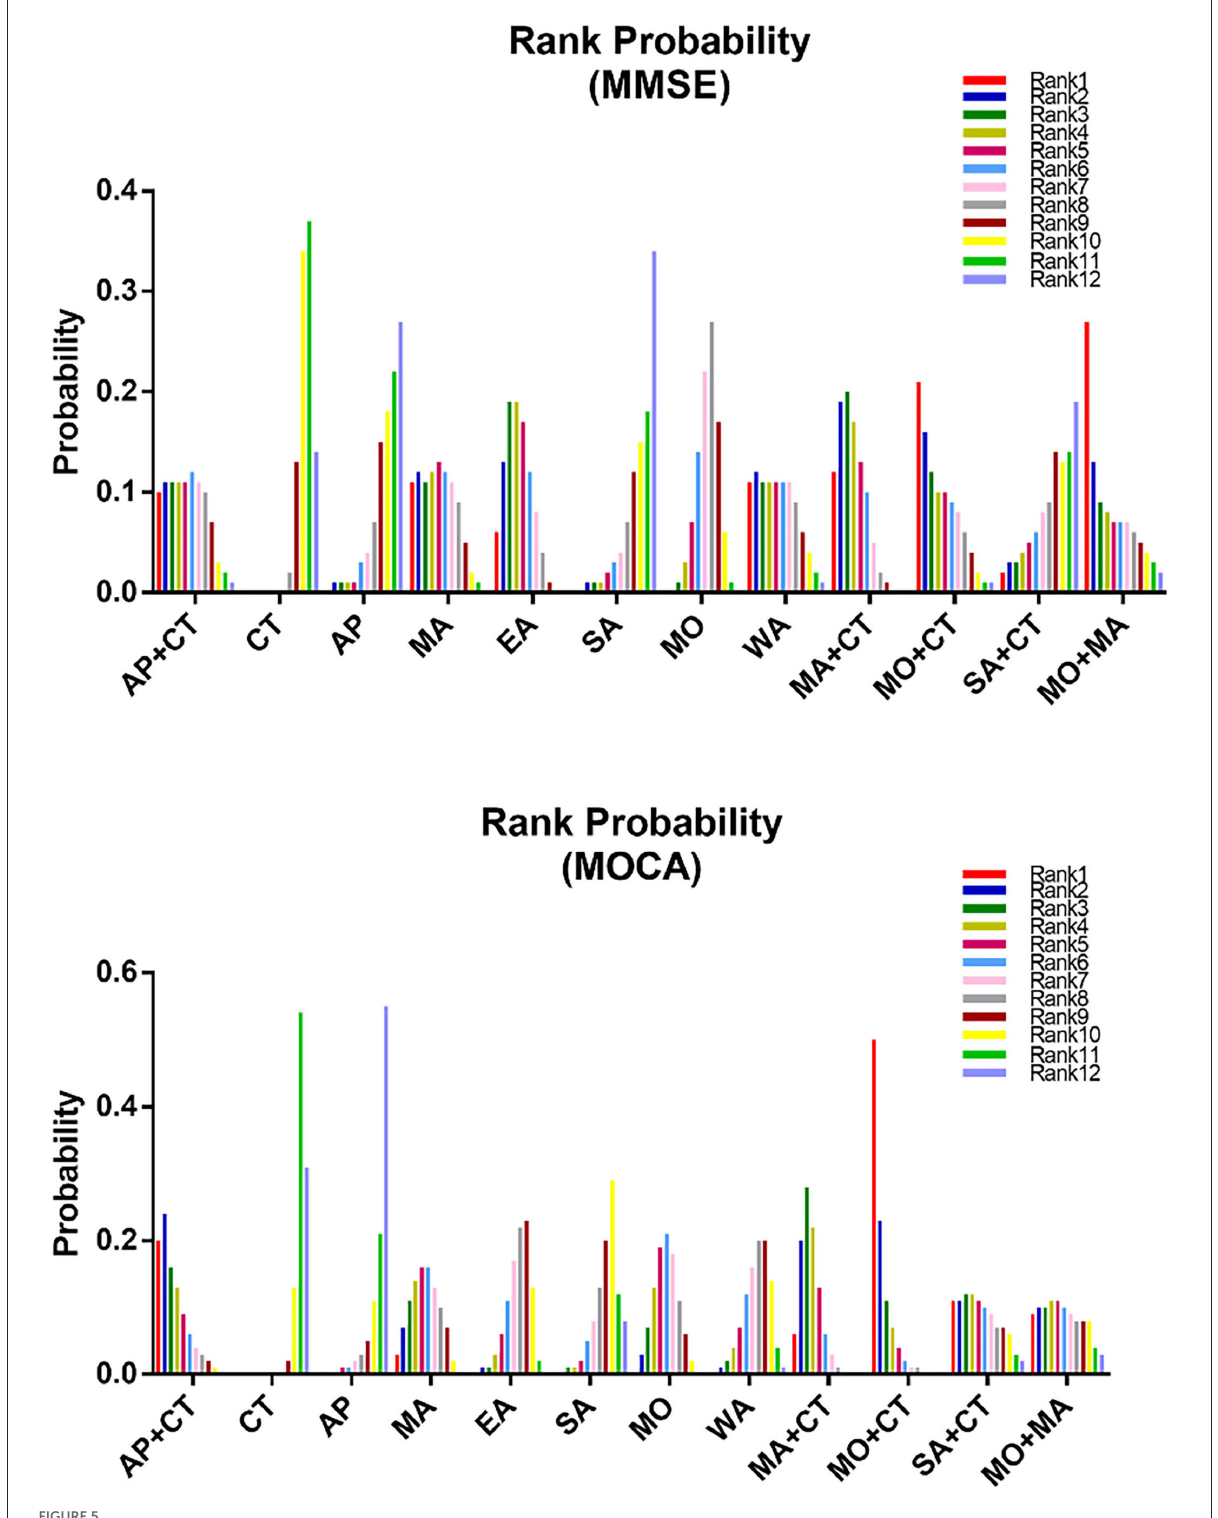
FIGURE5 Rank probability plot of network meta-analysis for MMSE and